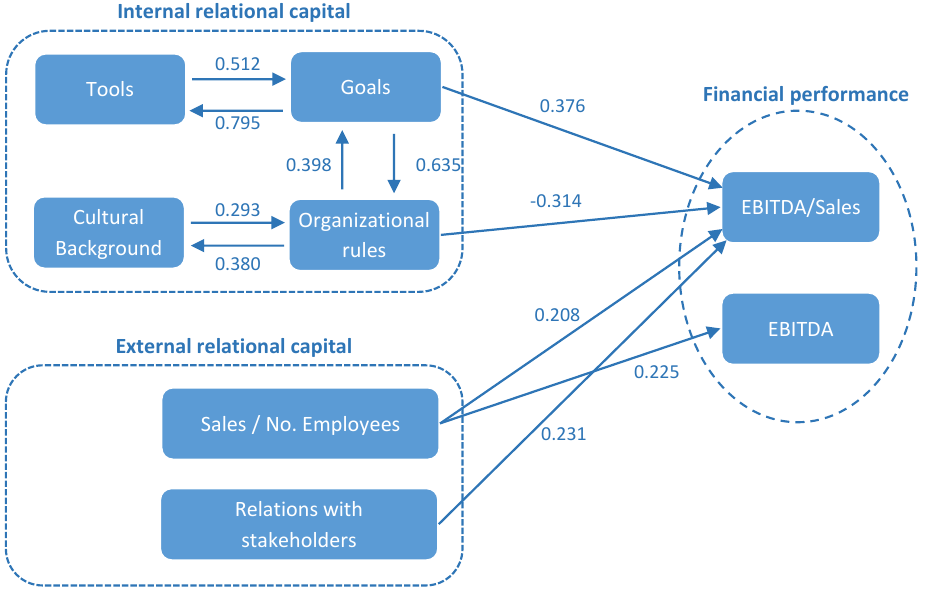
Figure 3. Framework of relations with β